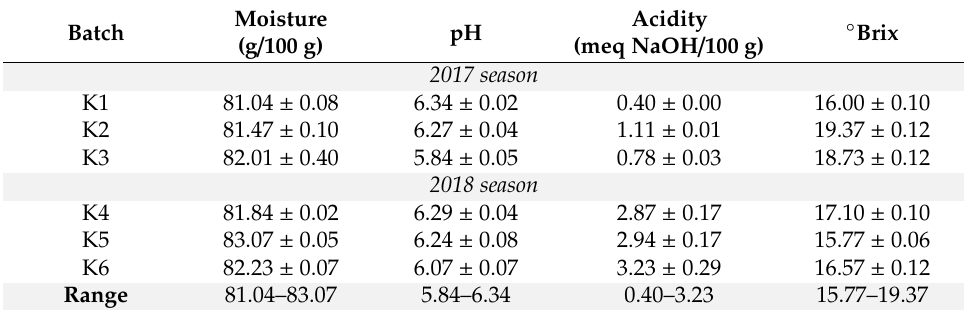
Table 2. Moisture, pH, acidity and ºBrix values of deastringed persimmon fruits (‘Rojo Brillante’ variety) were analysed in the 2017 and 2018 seasons. Results expressed as mean ± standard deviation ( n -1), n = 3. Average weight of persimmon fruits = 263.32